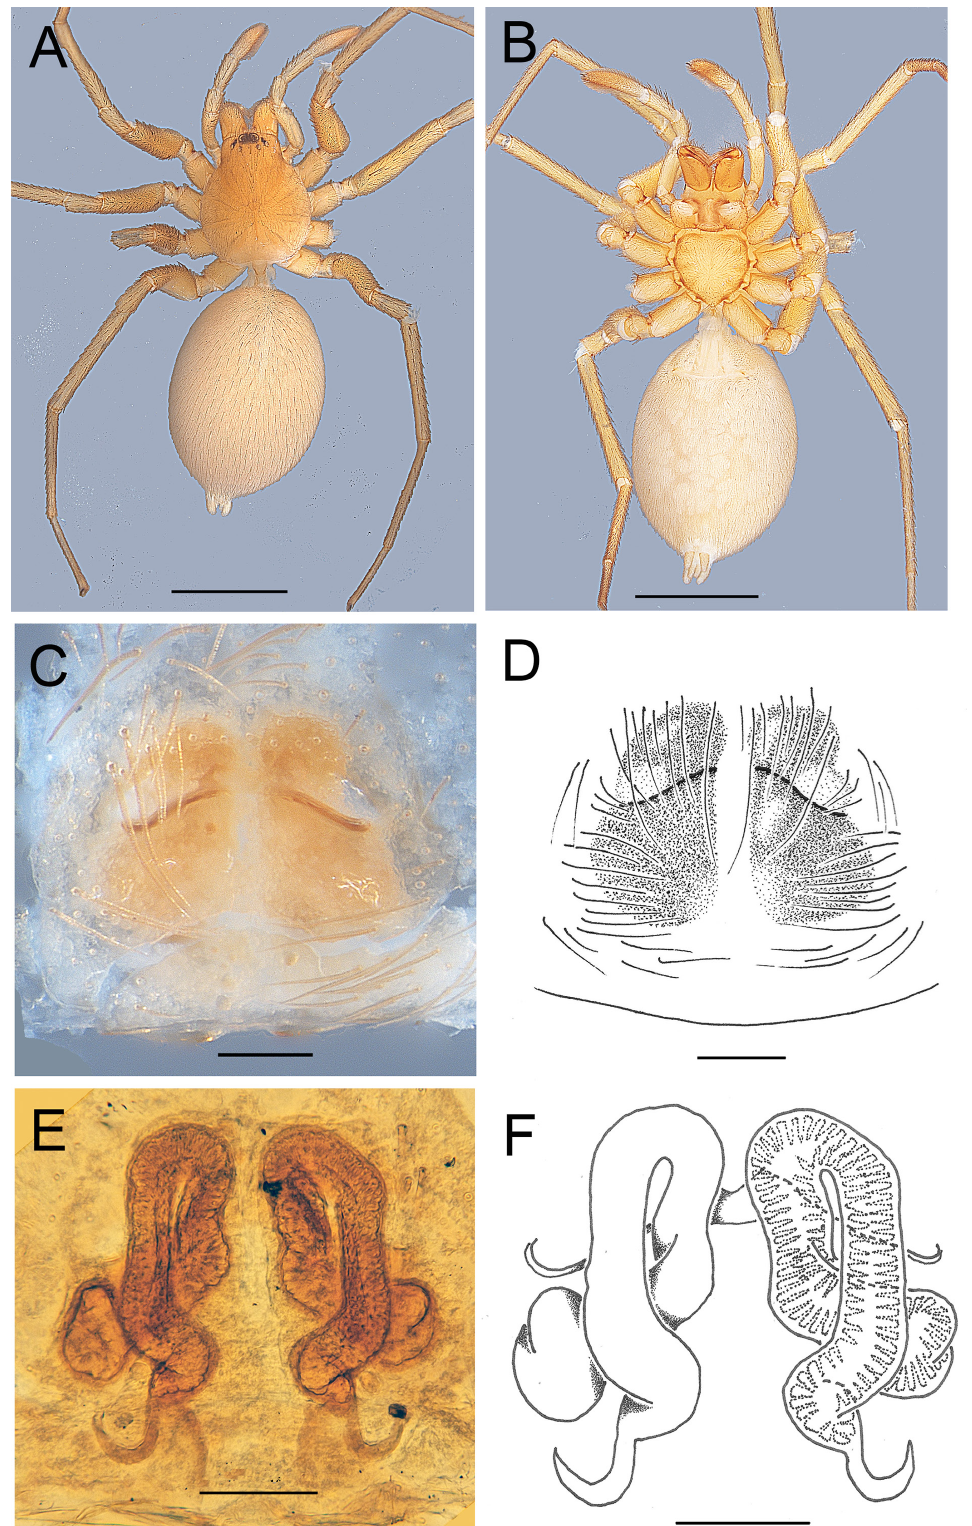
Fig. 26. Andromma heligmos sp. nov., ♀, holotype (BE_RMCA_ARA.Ara 140917). A . Habitus, dorsal view. B . Same, ventral view. C–D . Epigyne, ventral view. E–F . Same cleared, dorsal view. Scale bars: A–B = 2 mm; C–F = 0.1